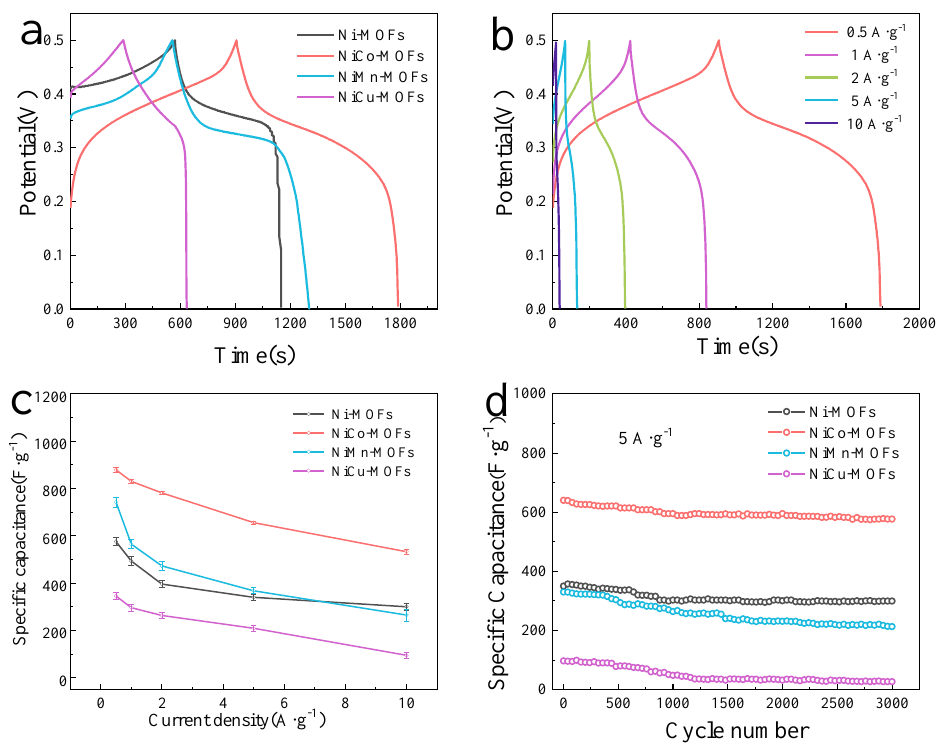
Figure 5. ( a ) GCD curves of four samples tested at 0.5 A · g − 1 ; ( b ) GCD curves of NiCo − MOFs at different current densities; ( c ) specific capacitance at different current densities for four samples; ( d ) cycling stability performance of four samples at 5 A · g − 1 .